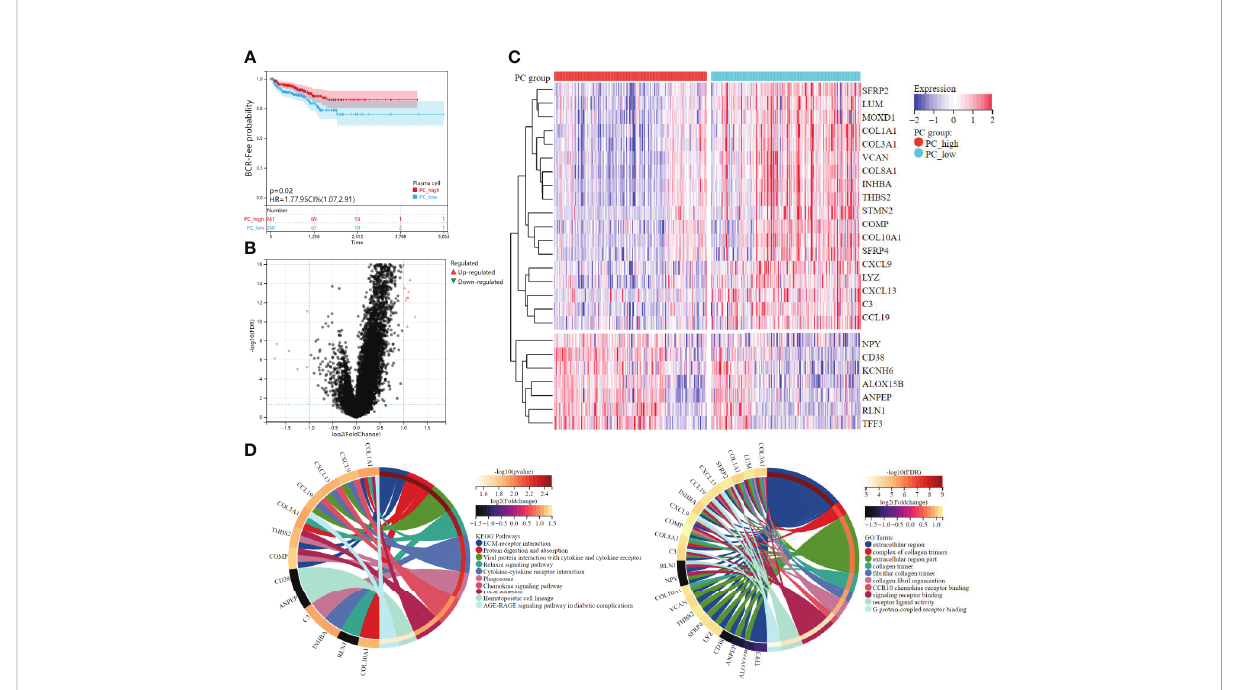
FIGURE 3 Survival analysis and differential expression between high and low plasma cell fraction groups. (A) The higher plasma cell fraction group had better biochemical recurrence-free survival. (B) Volcano plots of DEGS between high and low plasma cell fraction groups. (C) The DEGs heatmap showed the expression levels between two groups. Red and blue represented high and low expressions, respectively. (D) The functional enrichment analyses of DEGs, KEEG enrichment analysis is on the left and GO enrichment analysis is on the